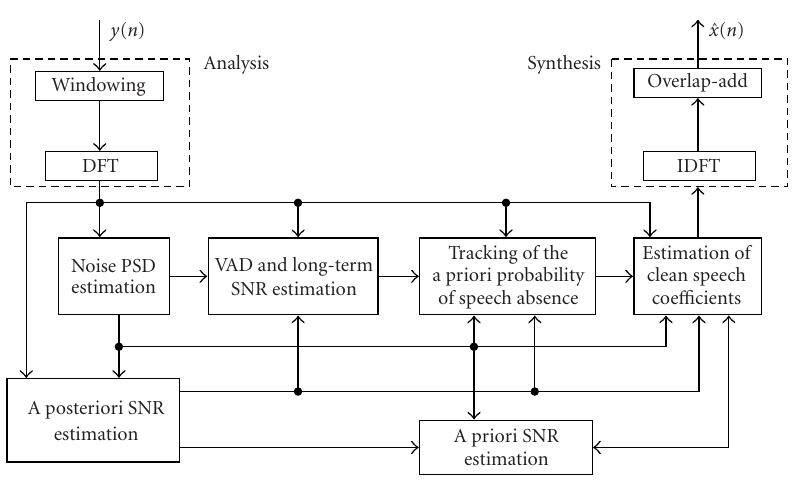
Figure 2: Block diagram of speech enhancement